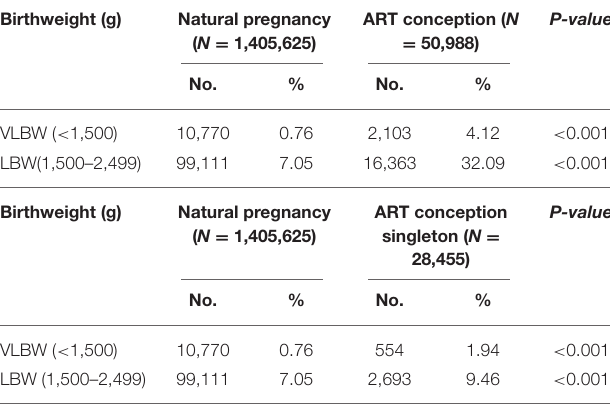
TABLE 2 | Proportion of very low birth weight (VLBW) and low birth weight (LBW) in natural pregnancy, ART conception and ART conception singleton in